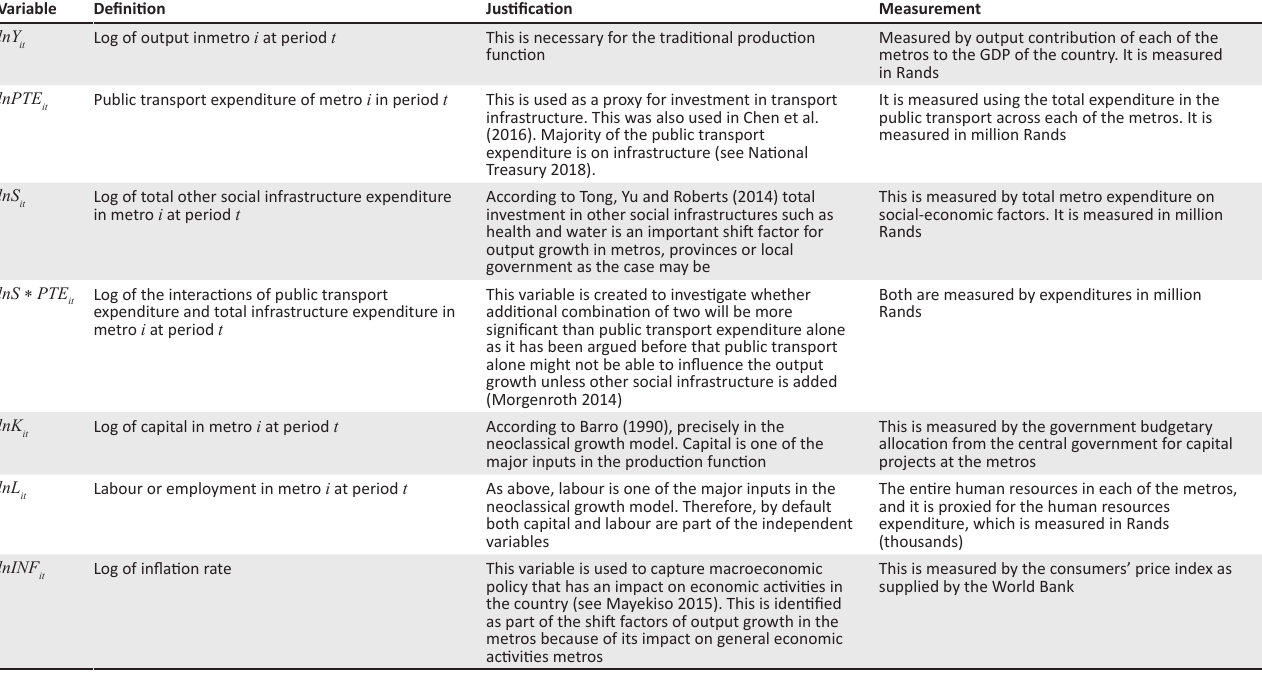
TABLE 1: Variables definition, justification and